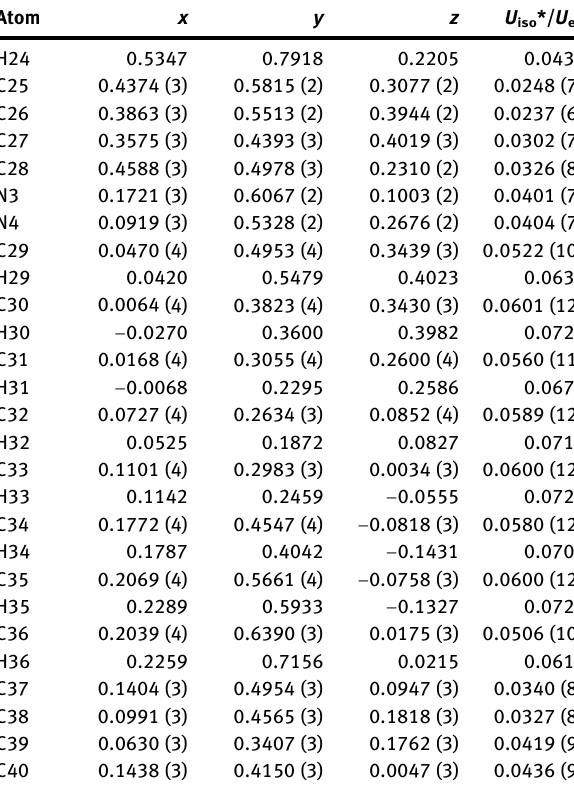
Table  : Fractional atomic coordinates and isotropic or equivalent isotropic displacement parameters (Å 